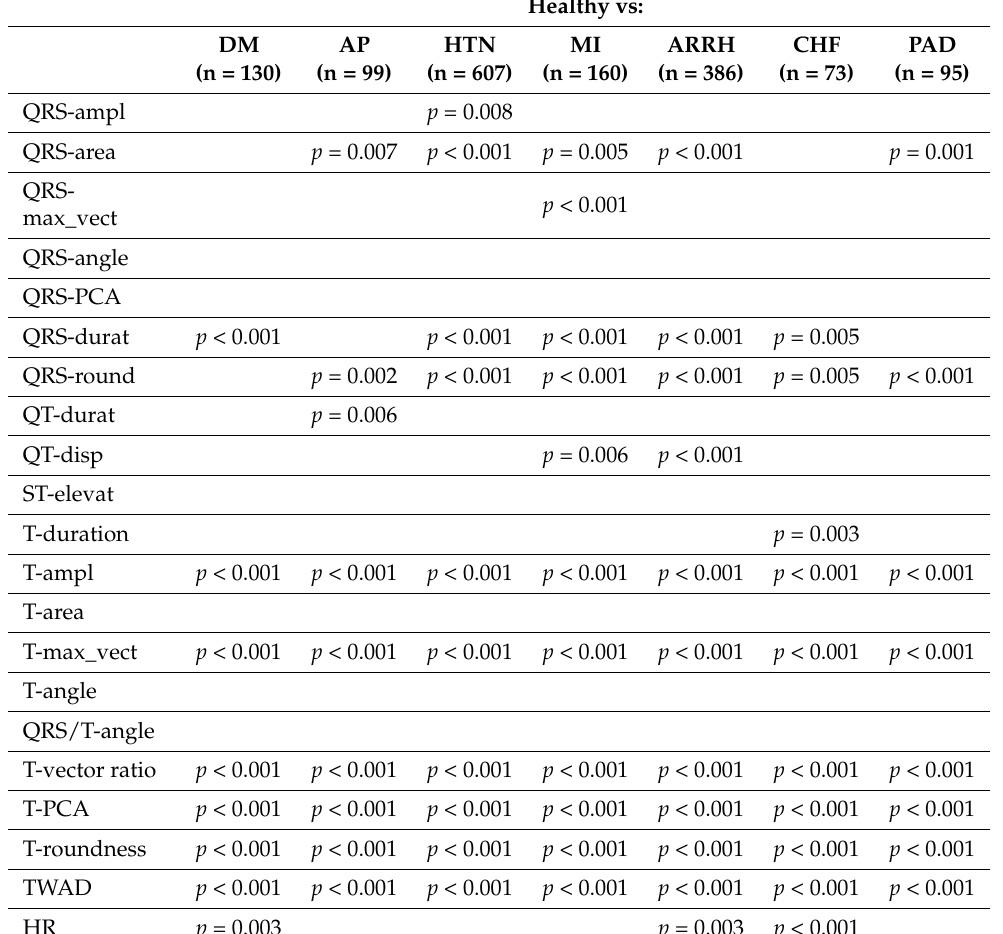
Table 3. Comparison of healthy vs. cardiovascular diseases and diabetes groups (significant p -values p < 0.01 were reported) considering 21 electrocardiographic and vectorcardiographic